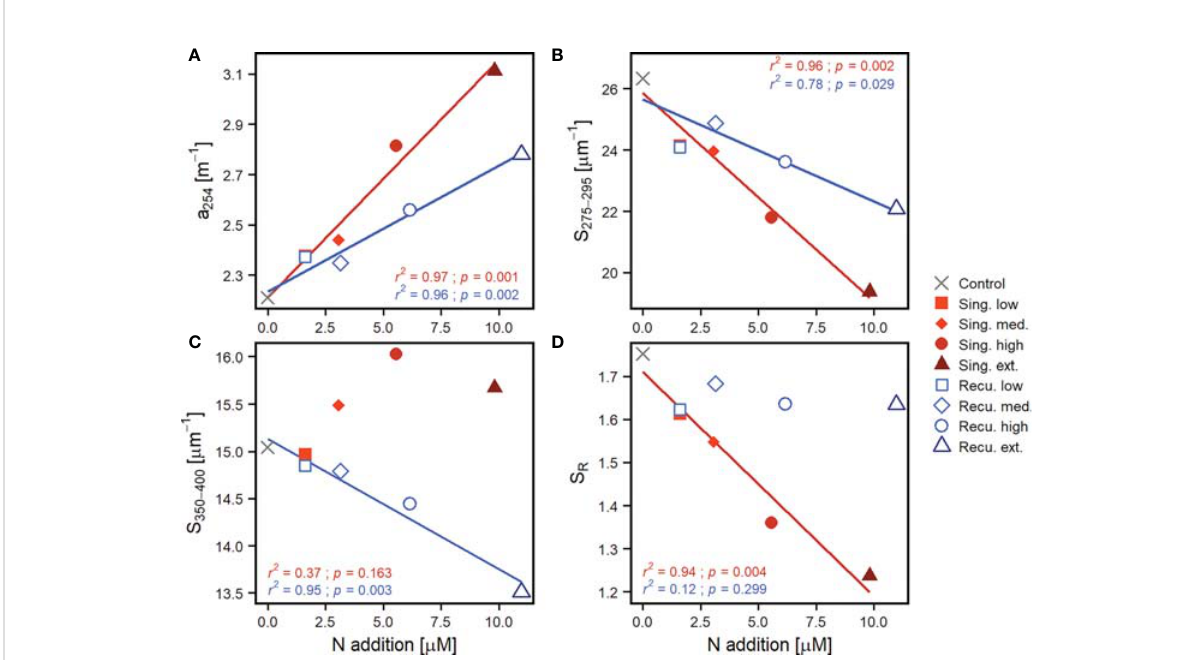
FIGURE 5 Linear regressions of average values after the last deep water addition to recurring treatments ( ≥ day 33) of (A) CDOM quantity as a 254 , (B) S 275- 295 , (C) S 350-400 and (D) S R against upwelling intensity (as N addition), per upwelling mode. The coef of the regressions are included. Only lines for signi fi cant regressions ( p < 0.05) are displayed. Regression parameters are detailed in Table